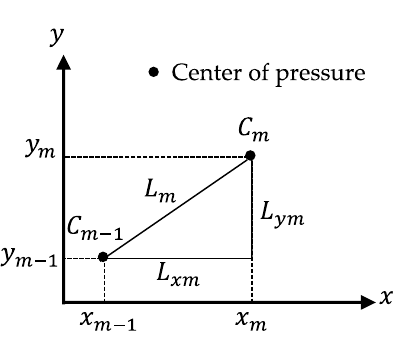
Figure 6. Conceptual diagram of the center of pressure (COP) length.